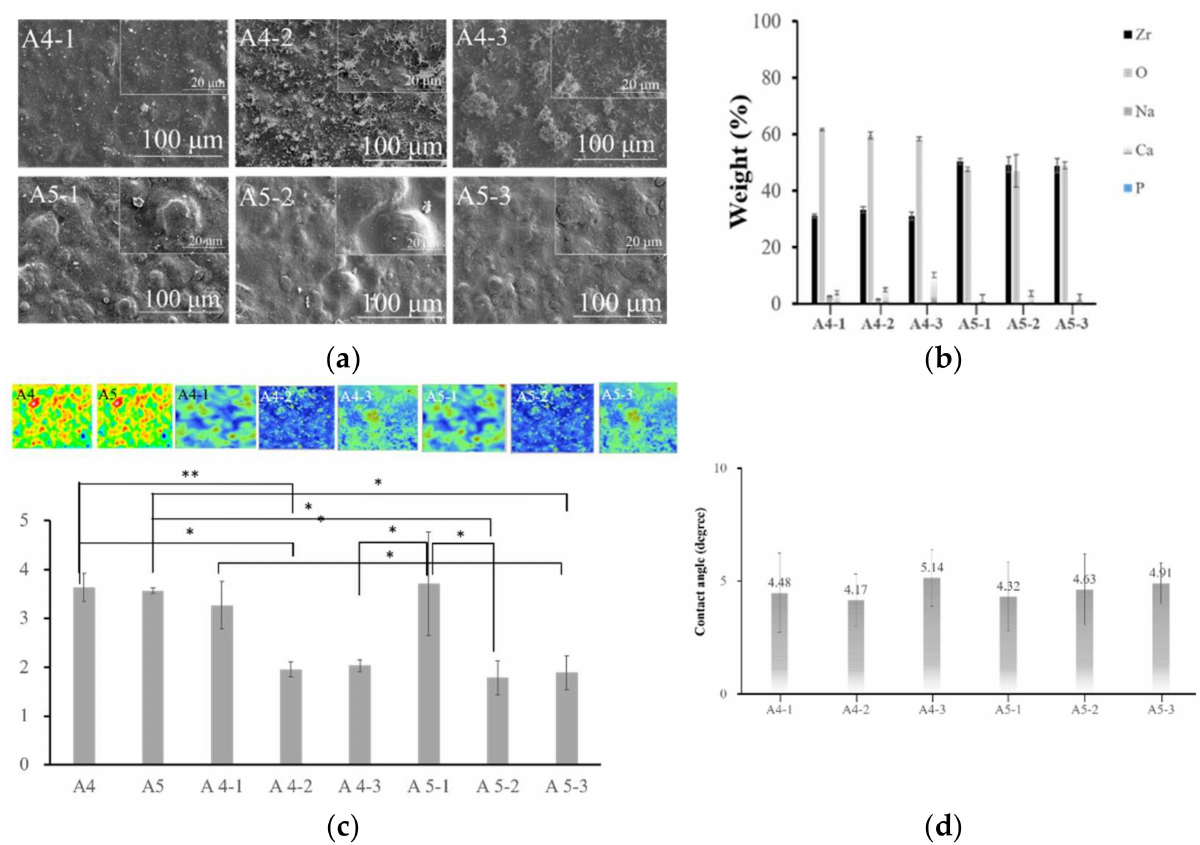
Figure 6. ( a ) Surface morphology of soaking in calcium hydride of A4 and A5. ( b ) Samples soaked in different concentrations of calcium hydroxide material surfaces at A4 and A5 substrates were analyzed via EDS. ( c ) Surface roughness analysis. Comparison of the surface roughnesses of A4 and A5 as the substrate after calcium hydroxide alkaline treatment (* p < 0.05; ** p < 0.01). ( d ) No significant difference. Comparison of the surface hydrophilicity after soaking in calcium hydroxide.